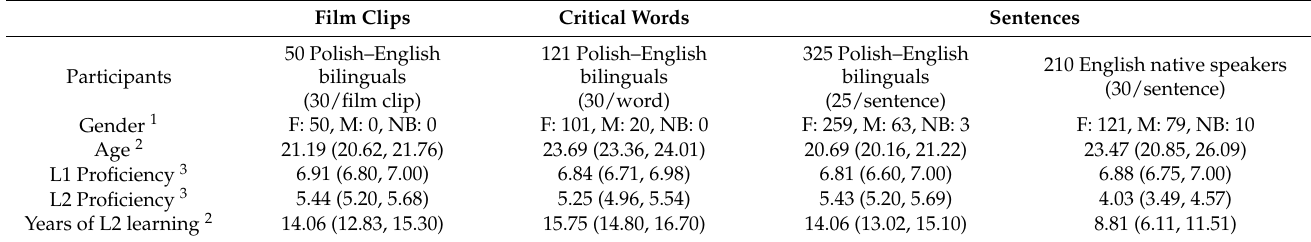
Table 4. Participants’ characteristics—all normative tests (means with 95% CI).